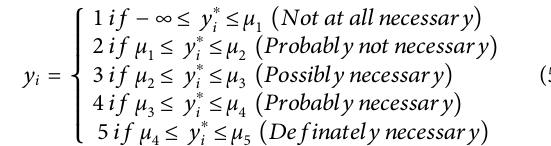
Frontiers in Built Environment |